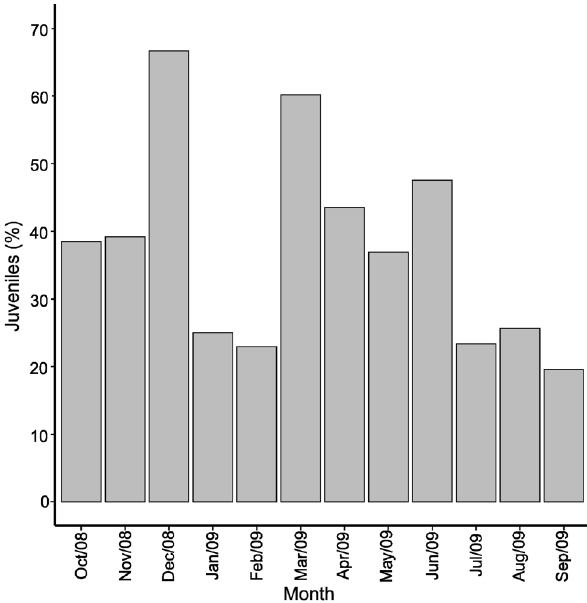
Figure 4. Frequency of juveniles (%) of Uca maracoani by